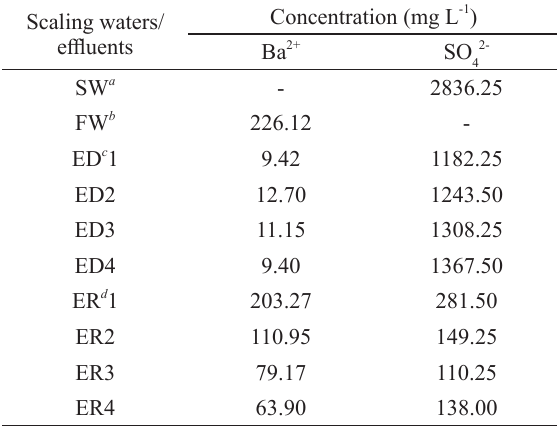
Concentration (mg L -1 ) of Ba 2+ and SO 42- obtained by IC from mono-phase flow